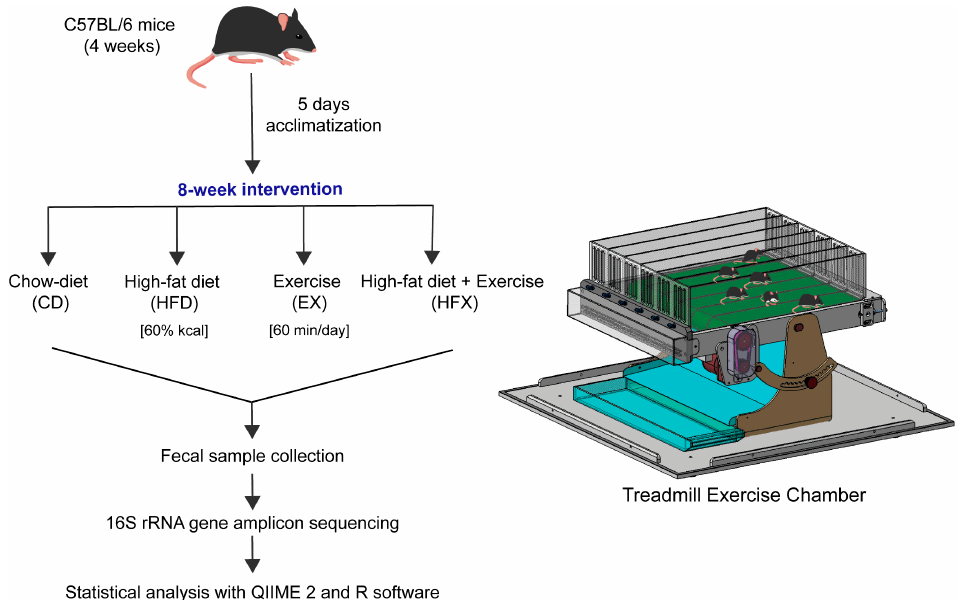
Figure 1. Research design for the analysis of the mouse gut microbiome using 16S rRNA gene amplicon sequencing.